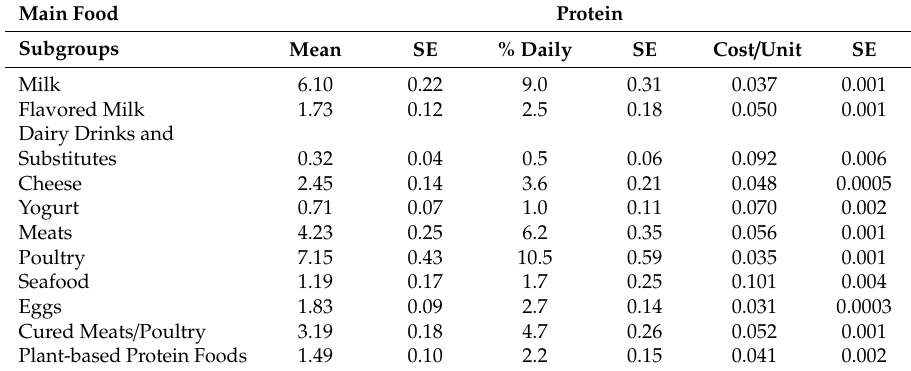
Table 7. Percent daily protein (g) and cost ($) of protein from eggs in children compared to USDA protein food subgroups.